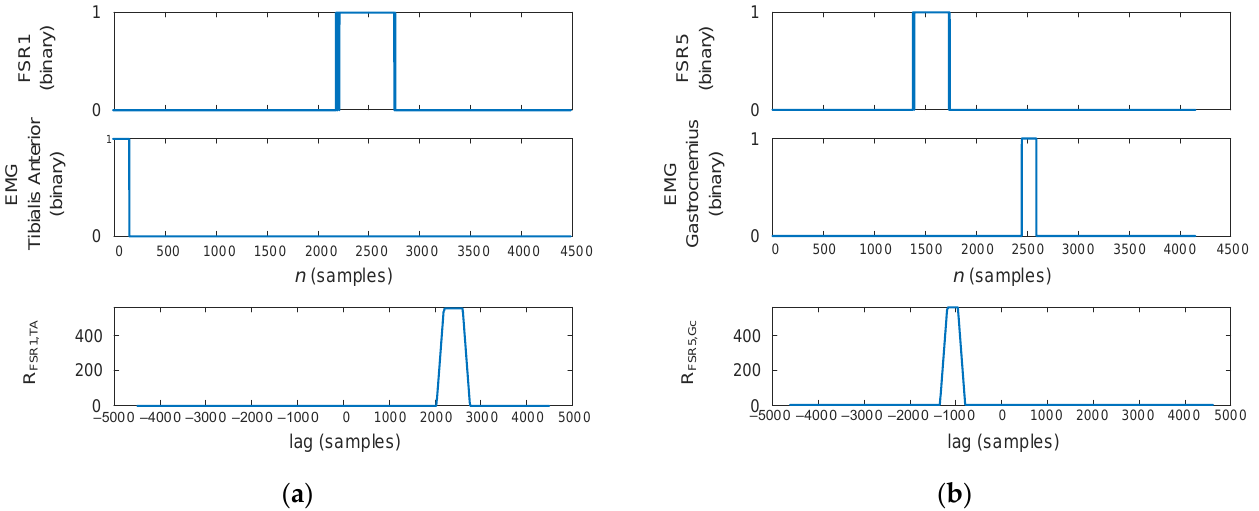
Figure 16. Illustration of the FSR and EMG lack of interdependency via the cross-correlation of the binarized FSR reading and EMG activation which does not have a maximum in the origin: ( a ) FSR 1 and tibialis anterior at heel strike, and ( b ) FSR 5 and gastrocnemius at toe-off.